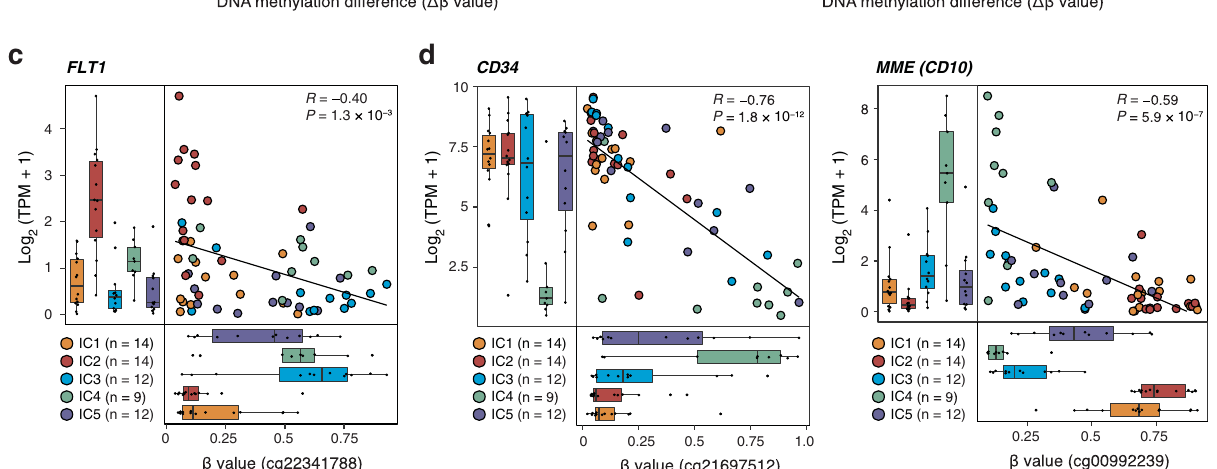
Fig.2|IntegrativecomparisonoftranscriptomeandDNAmethylomeininfant ALL. a , b Integrative scatter plots contrasting expression differences with DNA methylation differences in IC2 ( a ) and IC4 ( b ). Genes and probes with signi fi cant differences in gene expression (|log 2 fold change| ≥ 2 and two-sided adjusted P <0.05) and DNA methylation (| Δβ | ≥ 0.2 and two-sided adjusted P <0.05) are